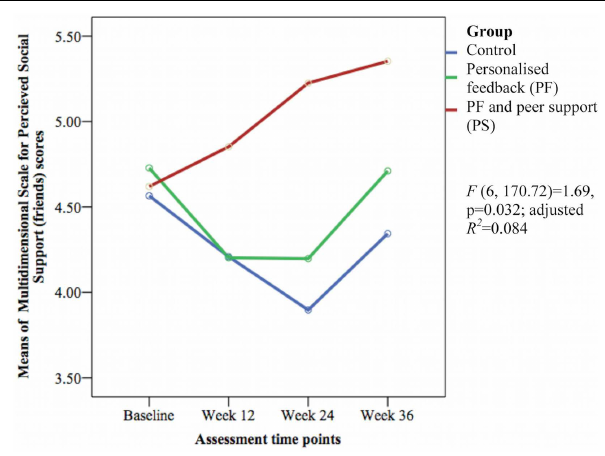
FIGURE 8 | Mean difference of Multidimensional Scale for Perceived Social Support (friends) scores between groups over time